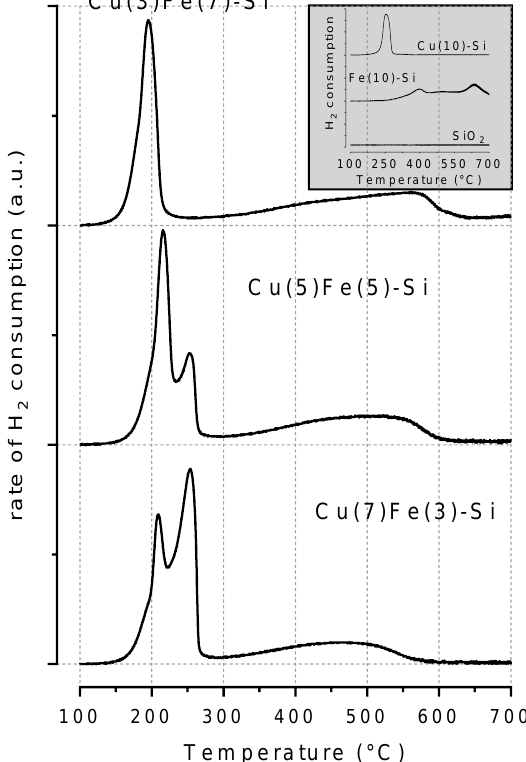
Figure 4. TPR profiles of the bi-metallic Cu(x)Fe(y)-Si catalysts. In the inset, the TPR profiles of the